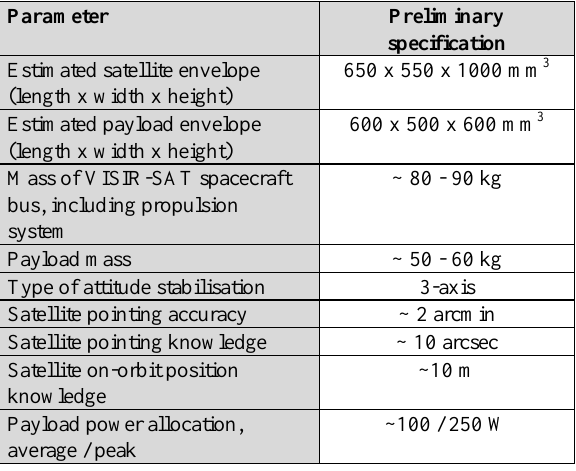
Table 3: Preliminary VISIR-SAT satellite bus